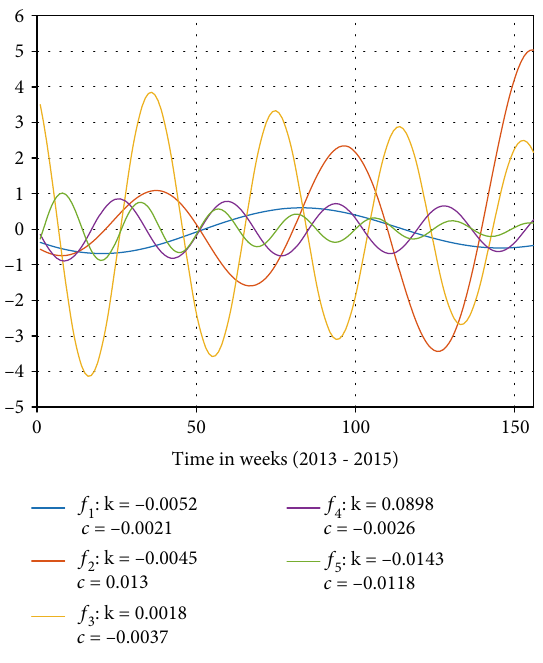
Figure 4: In fl uencing functions for m = 5